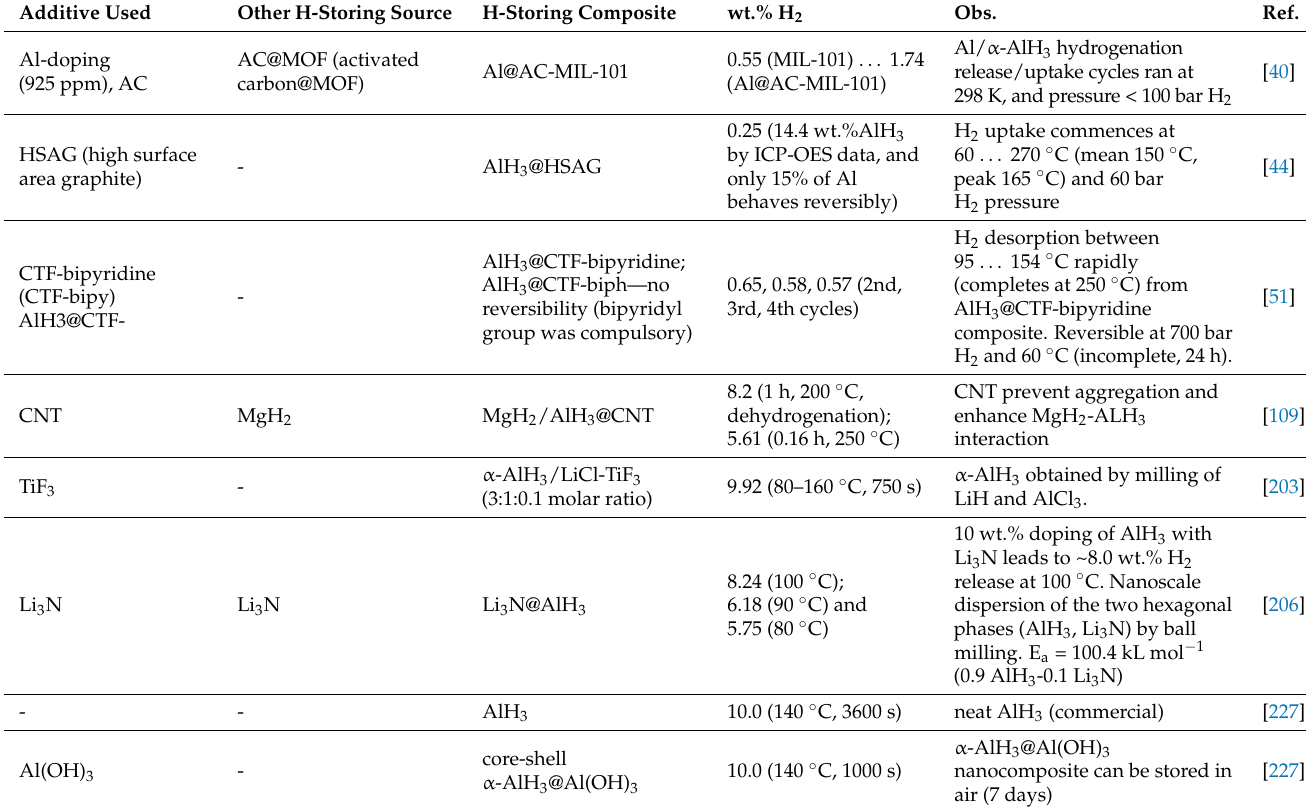
Table 12. Hydrogen storage features of nanosized AlH 3